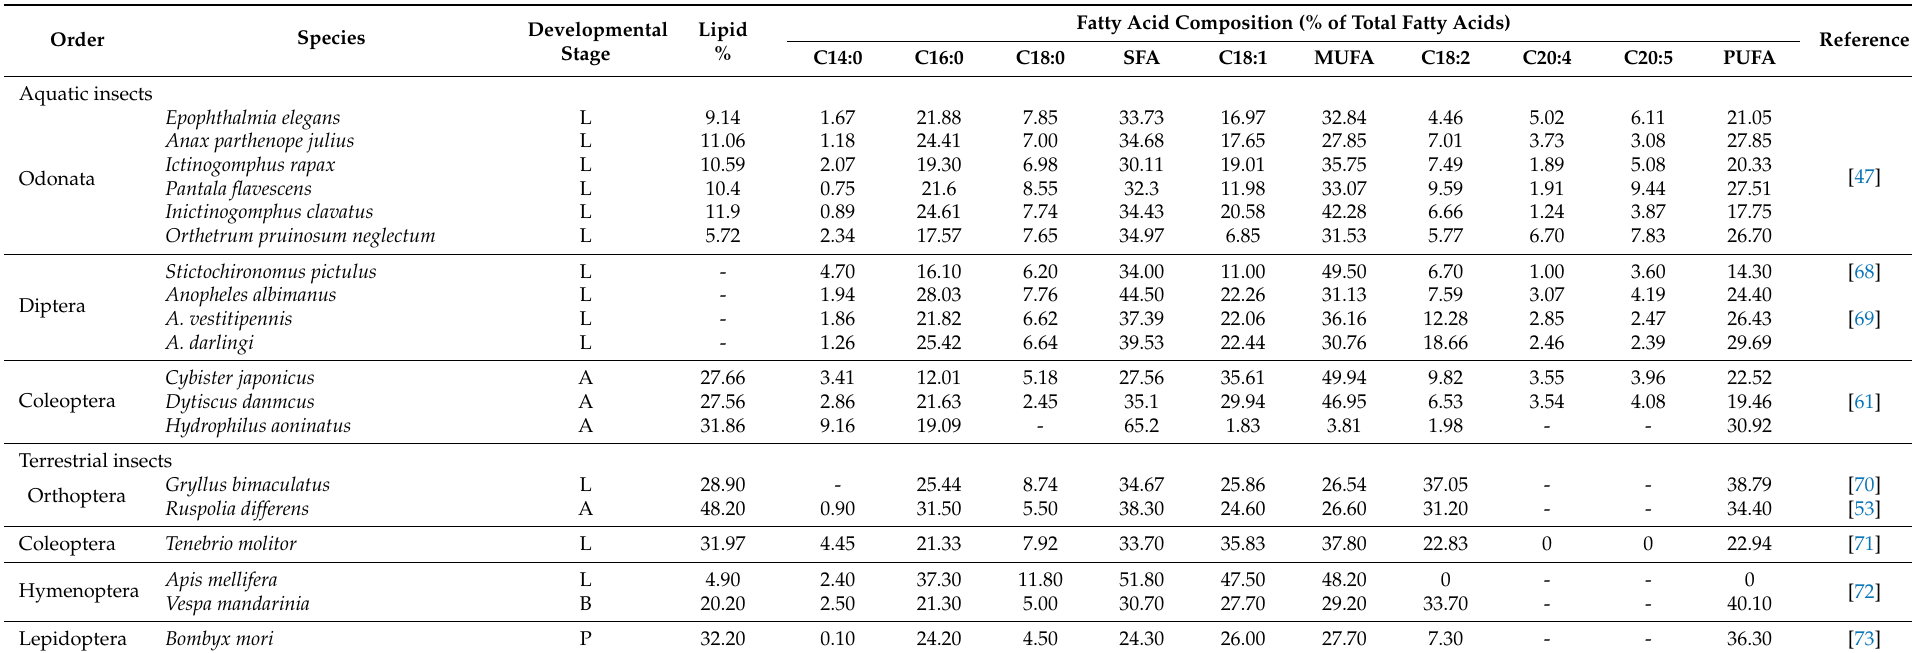
Table 3. Fatty acid composition of edible aquatic insects and selected edible terrestrial